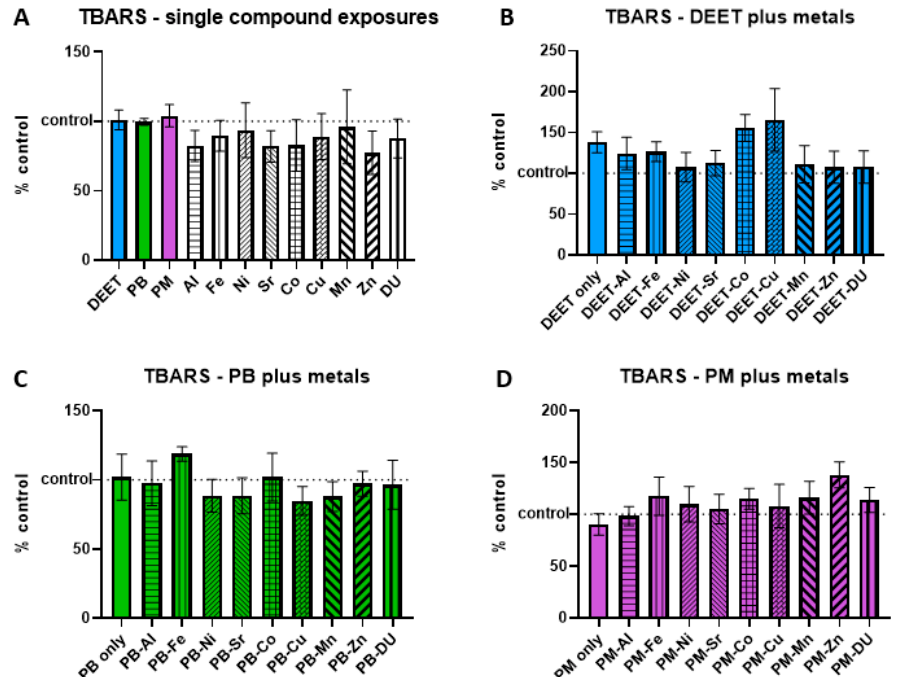
Figure 3. Thiobarbituric acid-reactive substances (TBARS) in brain microvascular endothelial cell (BMEC) cultures after organic compound and metal exposure. Assessment of thiobarbituric acid- reactive substances (TBARS) levels in BMEC cultures after exposure to organic compounds and/or metals. ( A ) organic compounds (10 µM) or metals alone (1 µM), ( B ) DEET (10 µM) plus metals (1 µM), ( C ) pyridostigmine bromide (PB) (10 µM) plus metals (1 µM), and ( D ) permethrin (PM) (10 µM) plus metals (1 µM). Dotted line at 100 indicates 100% of control measurement; values above the line indicate an increase in TBARS in the culture. Data represent the mean and standard deviation of three independent experiments. 3.4. Protein Carbonyl Protein carbonyl groups are carbonyl groups that form on protein side chains upon oxidation. BMEC cell cultures were exposed to a media-only control, organic compounds and metals singly, or in sets of each organic alone and in combination with each metal. Within each experiment, protein carbonyl signal was measured and normalized to the media-only control value and presented as percent of control, where 100% represents no change from control and indicated as a horizontal dashed line in graphs. Values above this line indicate an increase in protein carbonyl concentration, and thus a status of more stressed or damaged cell culture. In the single-compound experiments, only one compound was significantly different in a one-sample t -test of each % of control value when compared back to a value of 100; DEET had a lower than control amount of protein carbonyl (Figure 4A, t = 6.42, df = 2, * p = 0.02), suggesting the possibility of a protective effect. However, this effect was not seen in the DEET + metals exposure experiment, as DEET alone compared to control media was not significant ( t = 0.09, df = 3, p = 0.94). There were no significant differences in any of the metals in conjunction with DEET compared to DEET alone, either (Figure 4B, ANOVA F (9,30) = 0.43, p = 0.91). No significant effects of PB in conjunction with metals (Figure 4C, ANOVA F (9,30) = 1.48, p = 0.20) or of PM in conjunction with metals (Figure 4D, ANOVA F (9,30) = 1.81, p = 0.11) were detected either.